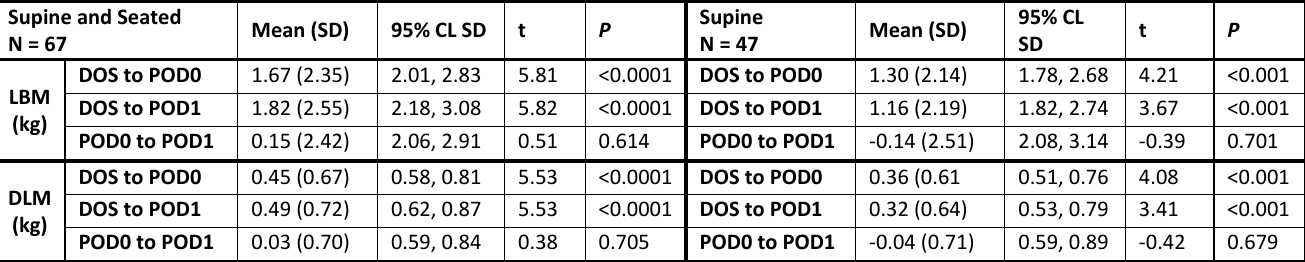
Table III. The results of the paired t-test between changes in dry lean mass (DLM) and lean body mass (LBM) at different peri-operative time points. Separate analyses by positioning (supine and seated – left side; supine – right side) are included. Supine and